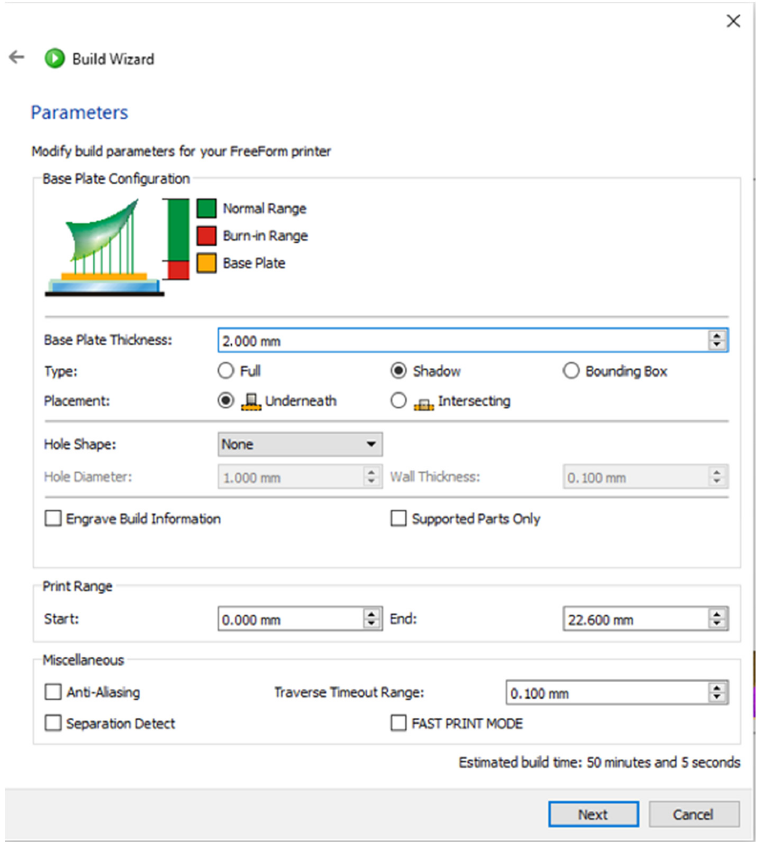
Figure 2. Asiga Composer—selected parameters for printing on the Build Wizard 3D printing